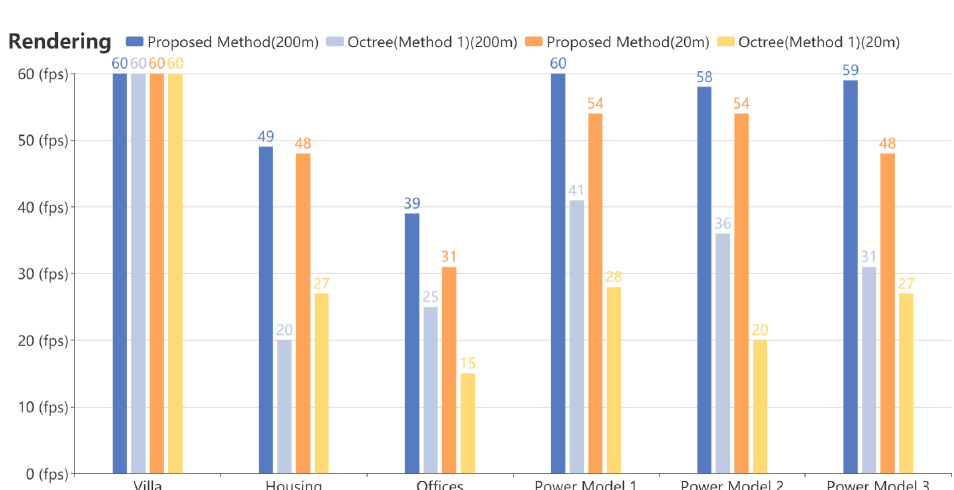
Figure 7. Rendering performance.